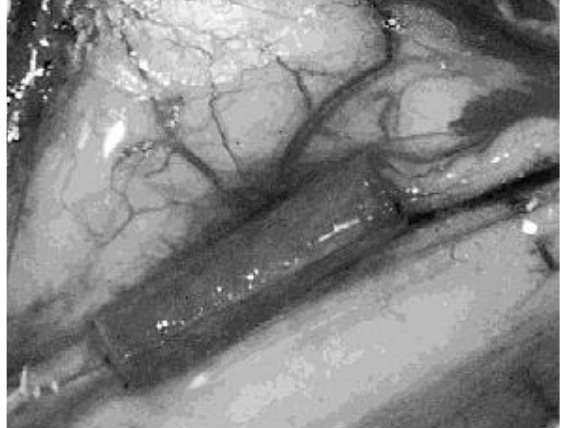
Figure 5. Superficial radial nerve of a cat sectioned and wrapped in a PHB conduit sealed by fibrin glue. Magnification 6x. Reused from (Ljungberg et al., 1999) [14] with kind permission of John Wiley and Sons.